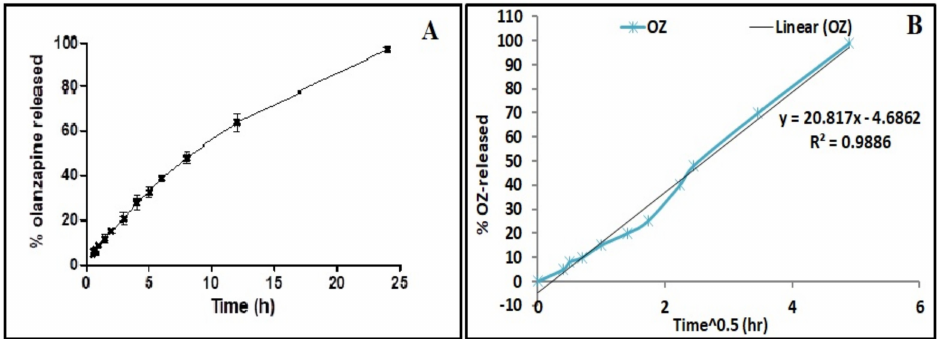
Figure 7. ( A ) In vitro release of olanzapine polymeric micelles in PBS pH 7.4. ( B ) Higushi equation for release kinetics of the selected OZ–PM formulae.